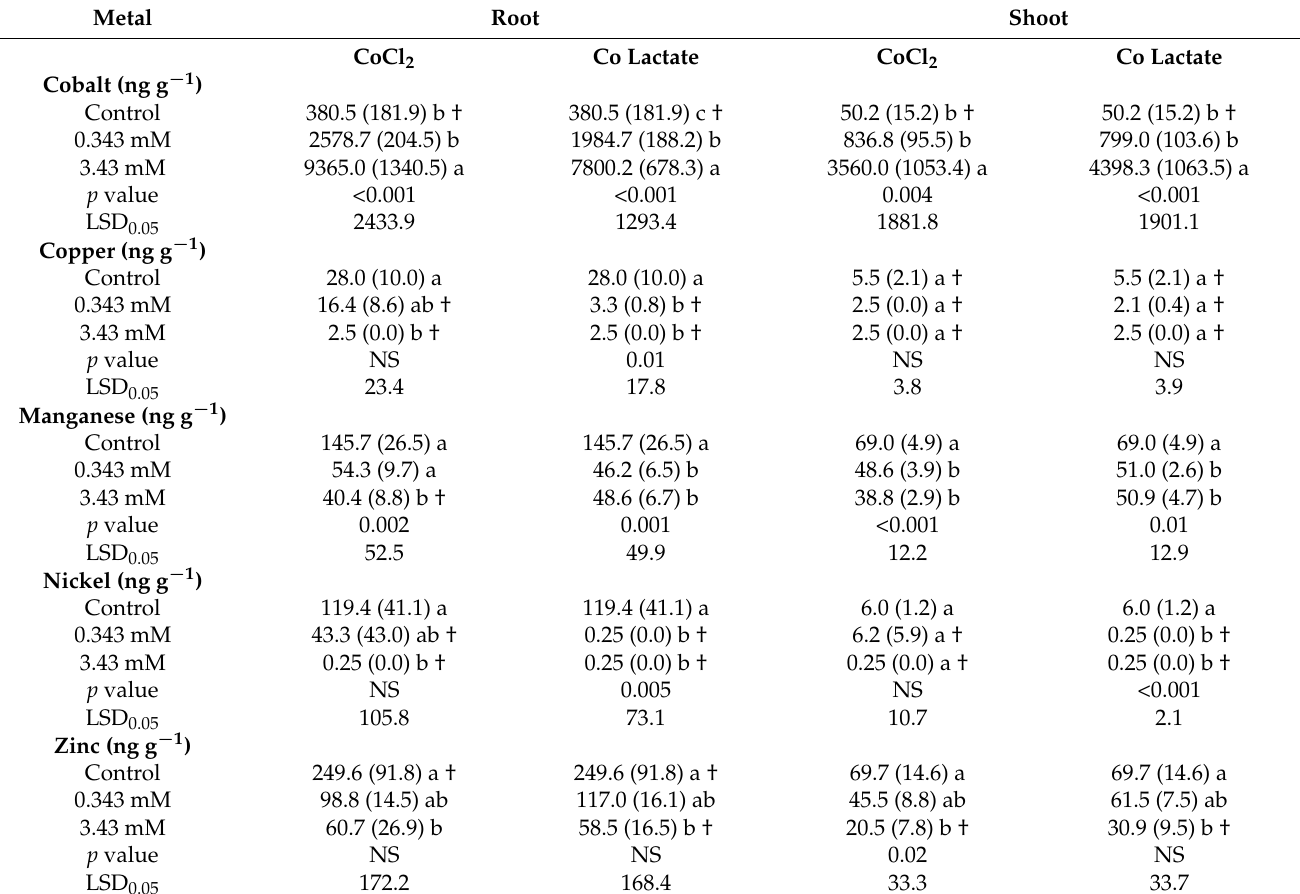
Table 10. Mean concentration of Co, Cu, Mn, Ni and Zn in the root and shoot tissues of wheat grown with cobalt chloride or cobalt lactate. Control samples did not receive any cobalt supplementation. Different letters indicate a statistically significant difference between treatment concentrations and control ( p < 0.05; Fisher’s LSD Test). The “†” symbol indicates that the mean was derived from one or more replicates with metal concentrations below the instrument detection limit (DL) and were substituted with values equal to the DL/2. No significant differences in tissue metal concentrations were detected between cobalt chloride and cobalt lactate at any concentration for any metal analyzed ( p < 0.05; simple t -test). Standard error is denoted in parenthesis; n = 5. NS: not